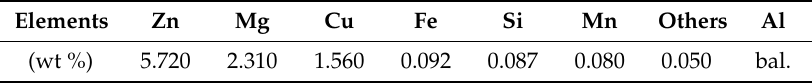
Table 1. The chemical composition of the as-received 7075 Al powder.